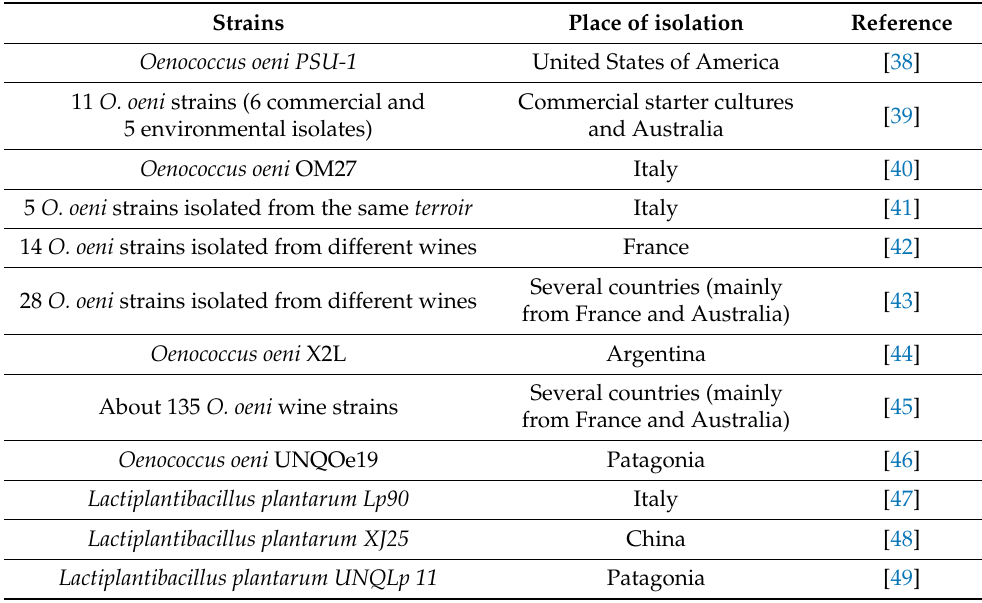
(Table 2), promoting knowledge improvements, molecular advances, and the application of “omics” approaches. Table 2. Information about literature on the complete genome sequences of wine LAB